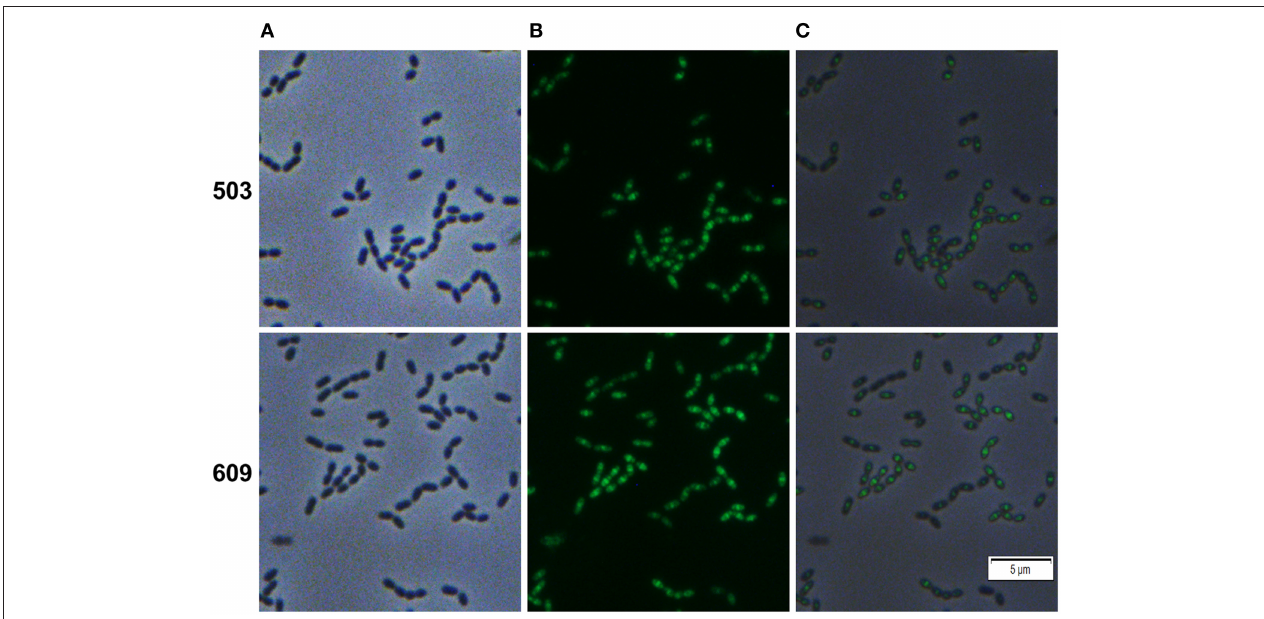
FIGURE 5 | Cellular localization of the hypothetical proteins SMU_503c and SMU_609 in S. mutans UA159. Xylose inducible reporter strains MR47 (SMU_503c) and MR48 (SMU_609) carrying GFP + fusions of the genes under the control of the XylS1 promoter cassette were grown in complex THBY medium. Upon entering the exponential growth phase (OD 600 = 0.25) strains were induced with 1% xylose and cultivated for further 3 h. Cells were harvested, washed and analyzed using fluorescence microscopy. Phase contrast (column A ), fluorescence (column B ) and overlay images (column C ) are presented. In the upper panel (503) the images derived from strain MR47 are presented, while the lower panel (609) shows the images of strain MR48.